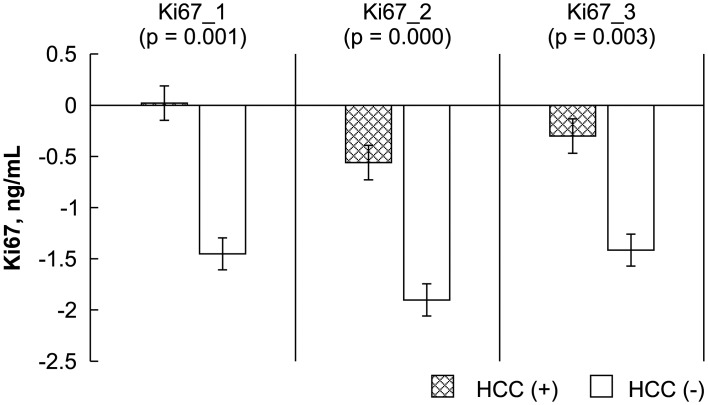
Statistical analysis of FGF-2, survivin, Ki67, endostatin, and VEGF levels, as measured by ELISA before (_1), early after (_2), and late after (_3) after living donor liver transplantation (LDLT).The Mann-Whitney U test was used to compare the differences in the biomarkers at the various time points between the recipients with and those without HCC recurrence.